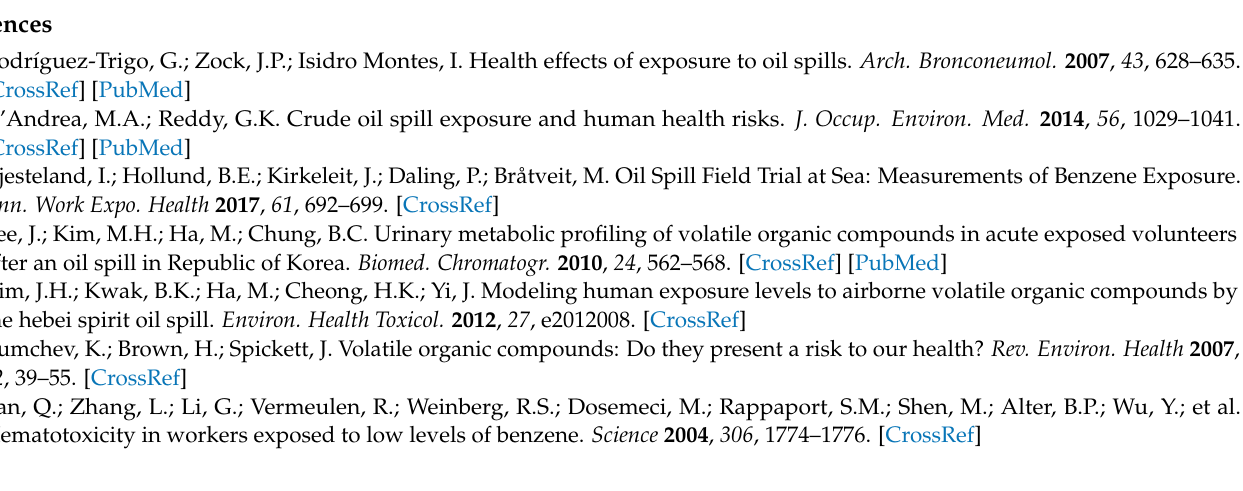
Table S2: Stratification by age in longitudinal associations between exposure to VOCs and loss of lung function up to 5 years after the very high environmental exposure to VOCs from the Hebei Spirit oil spill (n =